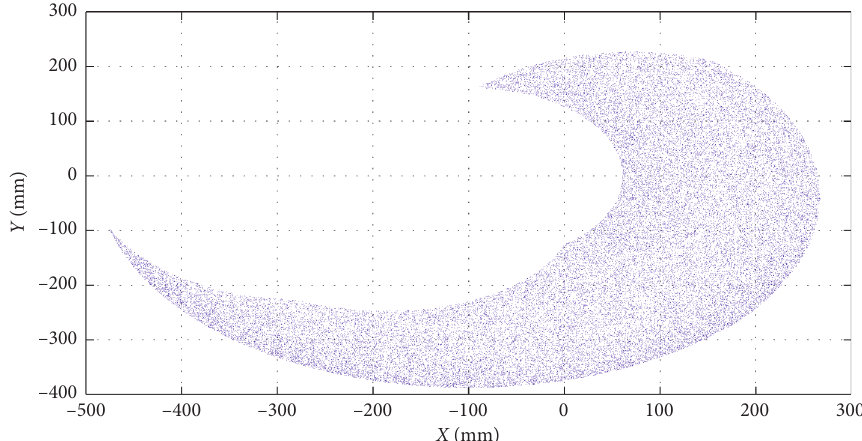
Figure 6: Workspace of leg